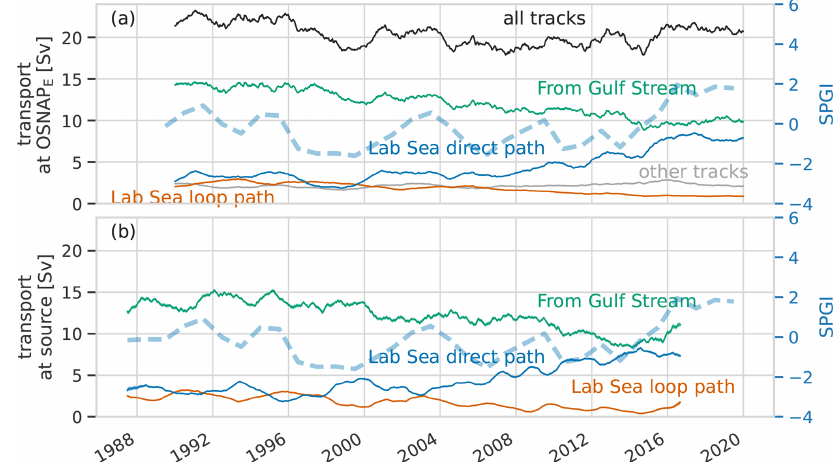
Figure 5. Time series of 1-year running mean volume transport across OSNAP E − 37W − 500m by source and pathway plotted against (a) the time at which water parcels cross OSNAP E and (b) the time that water parcels leave the source region. The total northward transport (black line) is higher in the 1990s and 2010s and lower in the 2000s. Transport from the Gulf Stream (green) reduces steadily after 1996. From the Labrador Sea, loop path transport (orange) also reduces steadily after 1996, while direct path (blue) increases rapidly after about 2008. Transport with an unidentified source after 10 years of backward tracking is coloured grey. Error bars at ± 1 . 96 standard deviations around the mean are included but are mostly too narrow to be visible here. The dashed blue line (and right-hand y axis) in (a) and (b) is the VIKING20X subpolar gyre index (SPGI) from Biastoch et al.